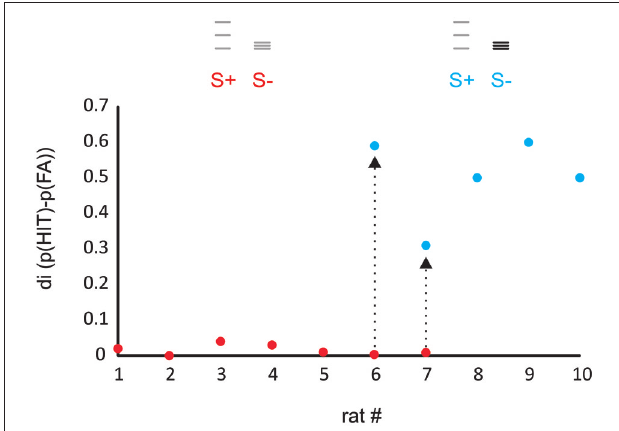
FIGURE 2 | Rats learn to discriminate ICMS amplitude but not spatial frequency . The plot shows the discrimination index (di, the difference between relative frequency of HIT and FA) for a task presenting virtual grids that differed in spatial frequency and range of grid bar positions (red dots, task 1) and a task that in addition offered differences in ICMS amplitude (blue dots, task 2). Rats 1–5 were trained exclusively with the first stimulus set and never learned the task. Rats 6, 7, after showing similar results on the first task were switched to task 2 and learned the task within several sessions (arrows). Rats 8–10 were trained only to task 2 and readily learned it. The icons depict the position of the virtual grid bars, gray: small ICMS amplitude, black: large ICMS